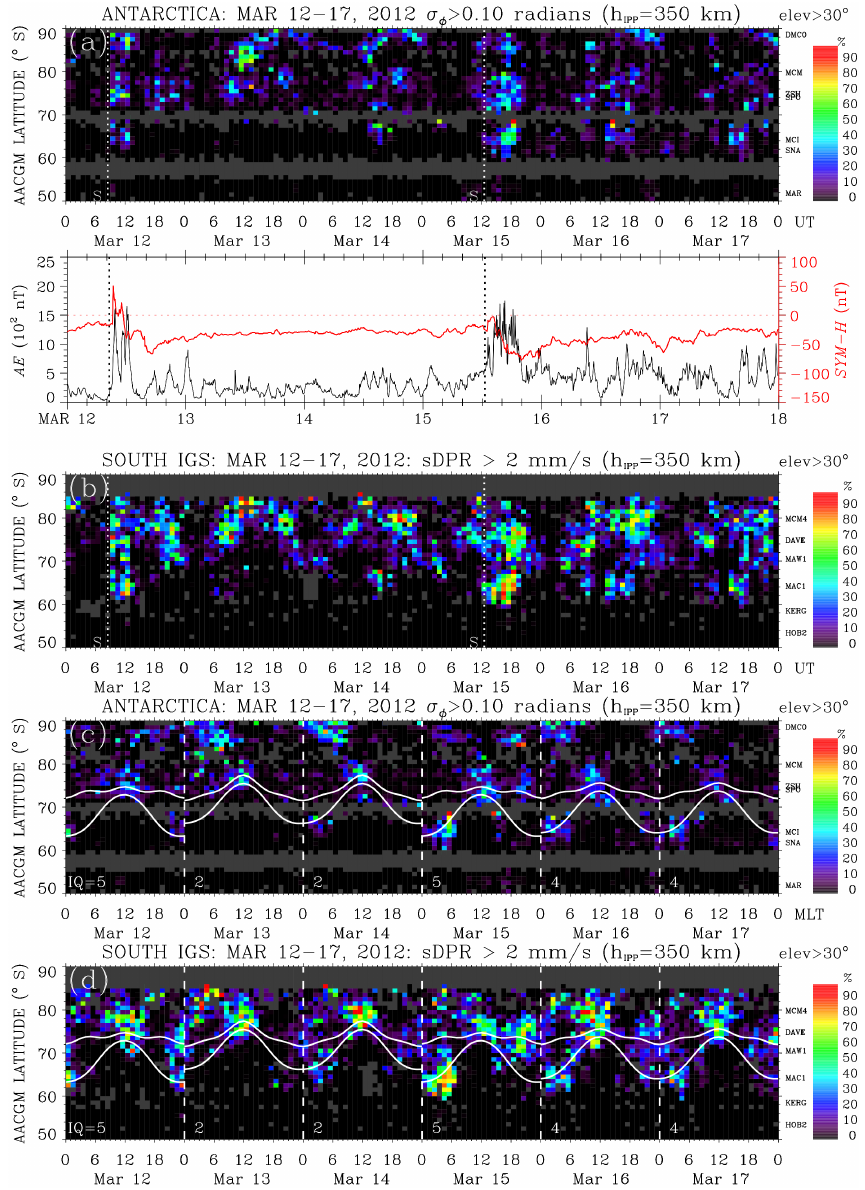
Figure 4. Same as Fig. 3 but for the interval from 12 to 17